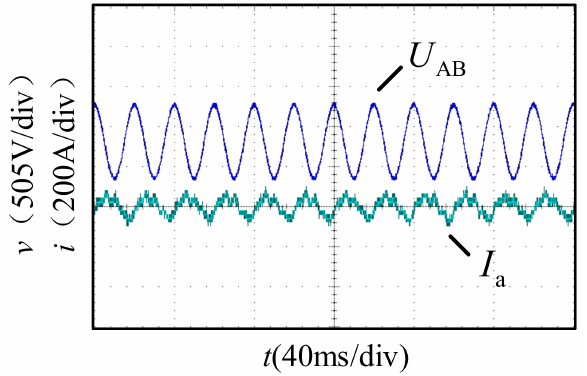
Figure 20. Experimental waveform of two inverters after